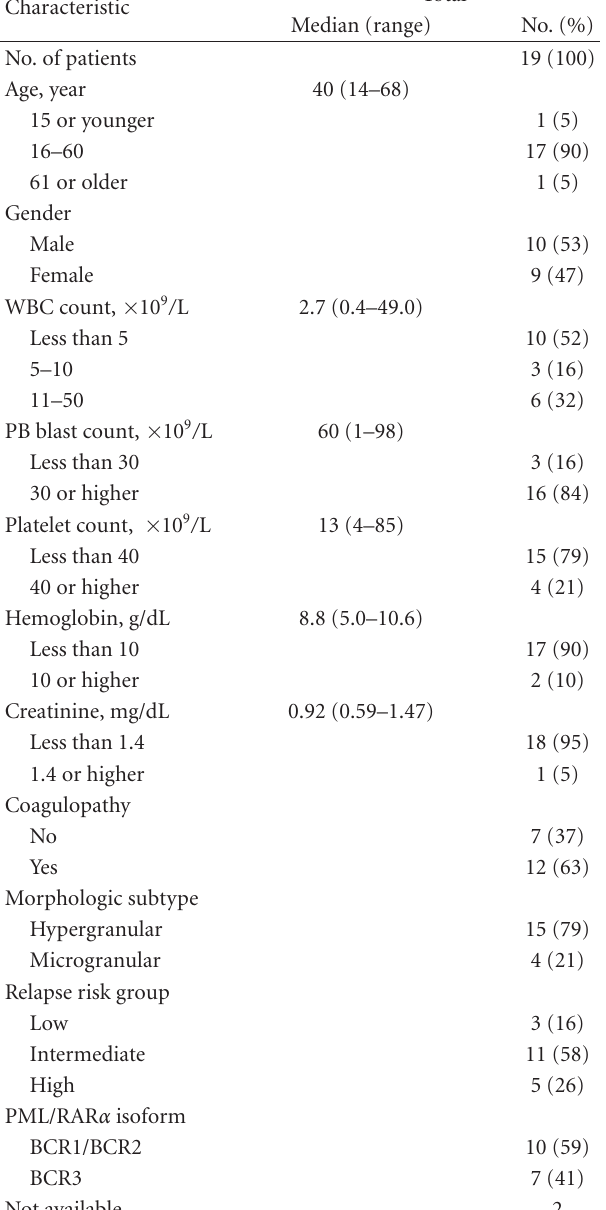
Table 1: Demographic and baseline characteristics of the study population.